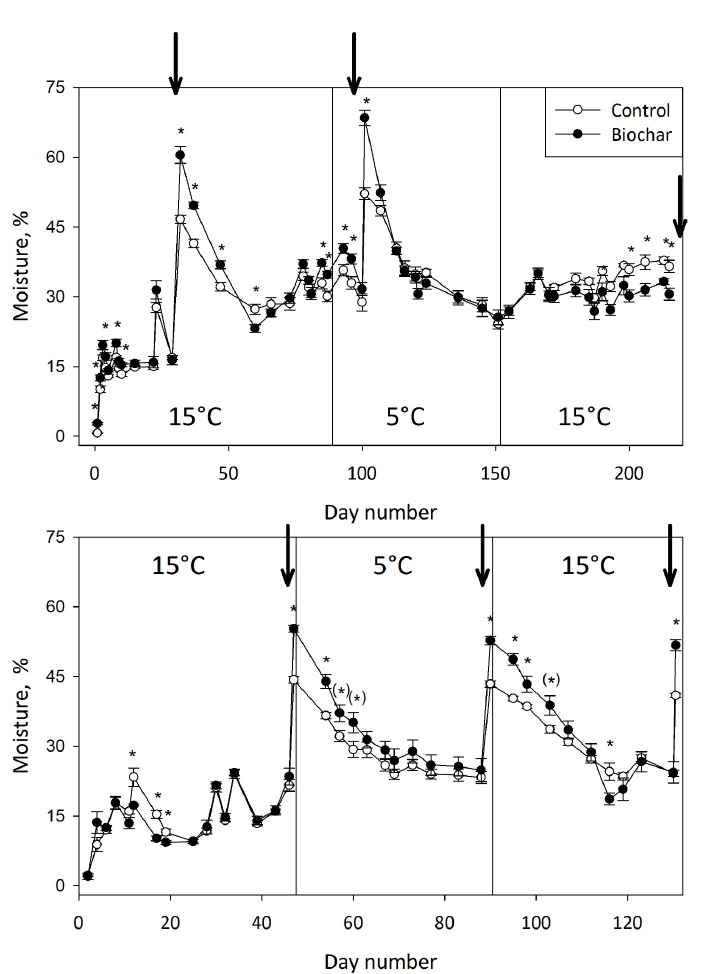
Fig. 3. Mean (± standard error of mean) volumetric soil moisture content at the depth of 0-6 cm on sandy till (upper, n=6) and medium fine sand (lower, n=5) experiments. * = statistically significant difference ( p < 0.05) between biochar treatments, (*) indicative difference (0.05 ≤ p ≤ 0.10) between treatments. Arrows indicate the moments of water